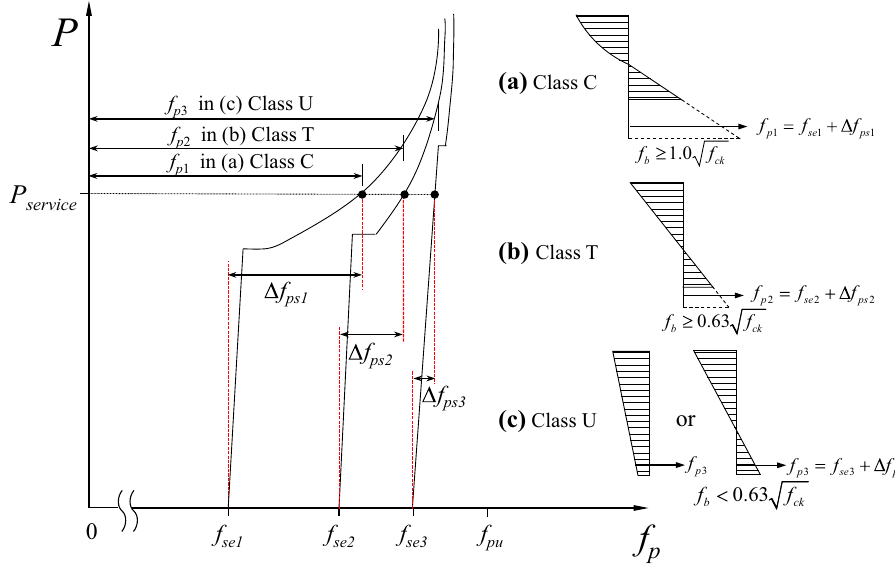
Fig. 1 Class of prestressed concrete sections and effect of effective prestress on D f